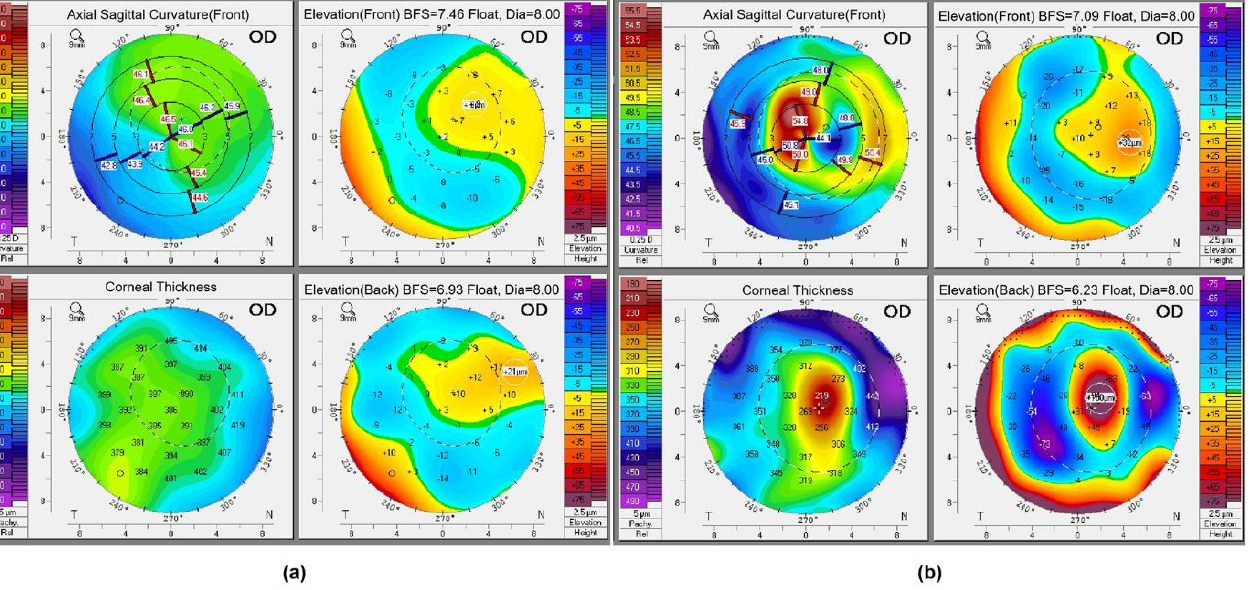
Figure 2. The 4 representative refractive maps of the ( a ) normal cornea and ( b ) ectatic cornea (4 weeks postoperatively) in rabbits obtained from Pentacam.